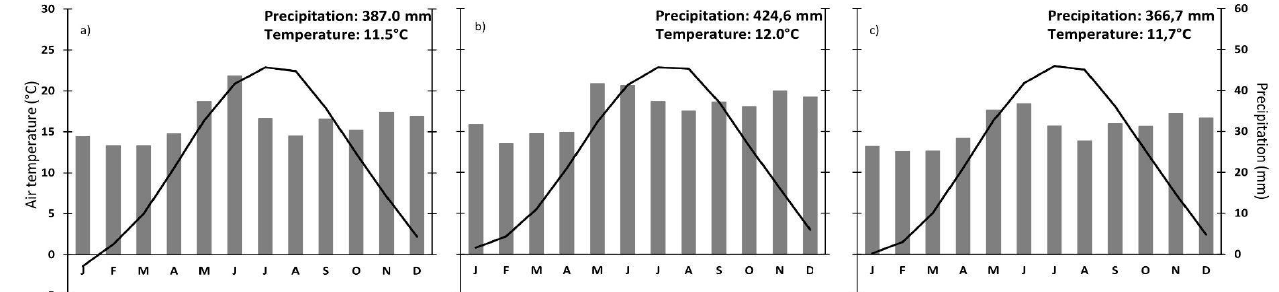
Figure 2. The multiannual mean variation of air temperature and precipitations at ( a ) Jurilovca, ( b ) Constanța and ( c ) Gura Portiței weather station from 1961 to 2020. Table 2. Multiannual monthly mean number of days with precipitations over 1 mm and monthly number of days with precipitations over 1 mm in 2013 and 2020 for Jurilovca, Constanța and Gura Portiței weather stations.